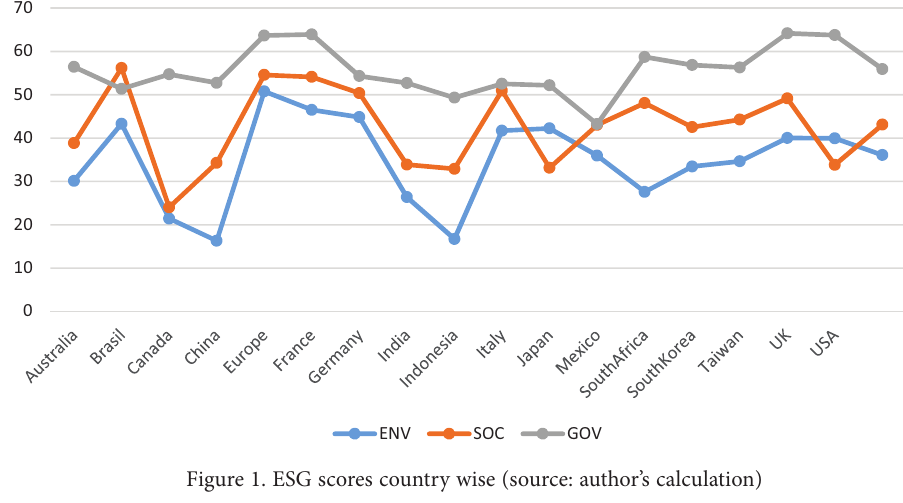
Figure 1. ESG scores country wise (source: author’s